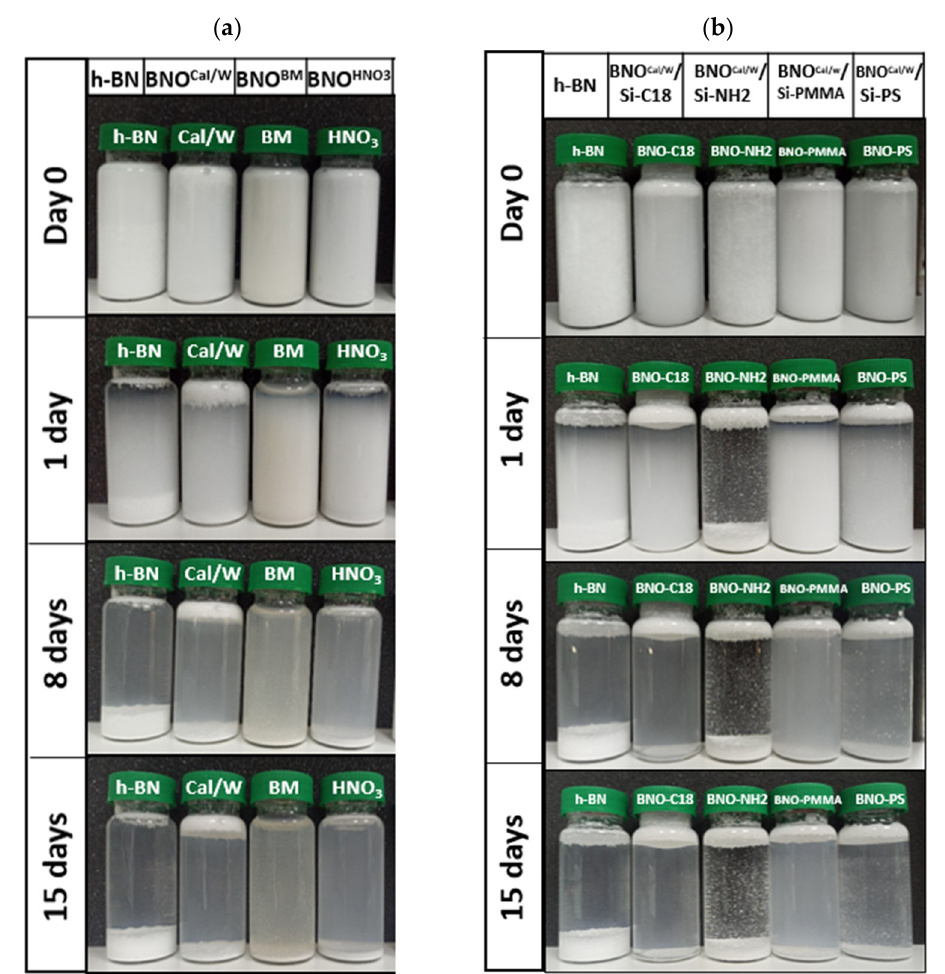
Figure 5. Photos of 0.6% wt suspensions in water. ( a ) Hydroxylated h-BN and ( b ) grafted BNO Cal .